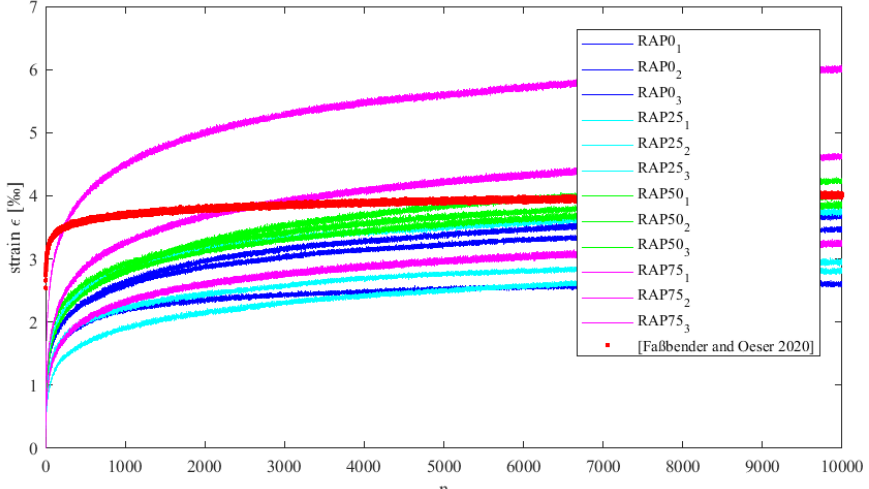
Figure 6. Strain of variants RAP0, RAP25, RAP50, RAP75 and mean strain of Ref. [3] due to the uniaxial cyclic compression test.